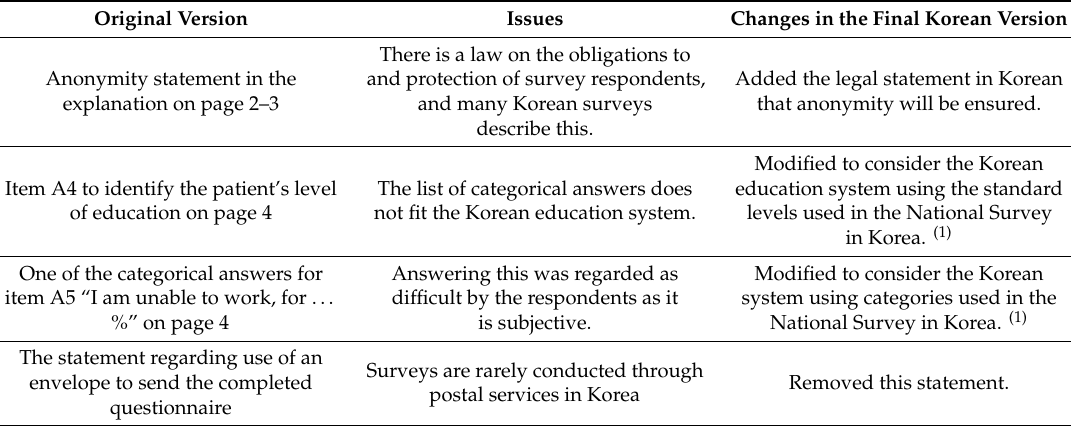
Table 1. Issues and changes in the